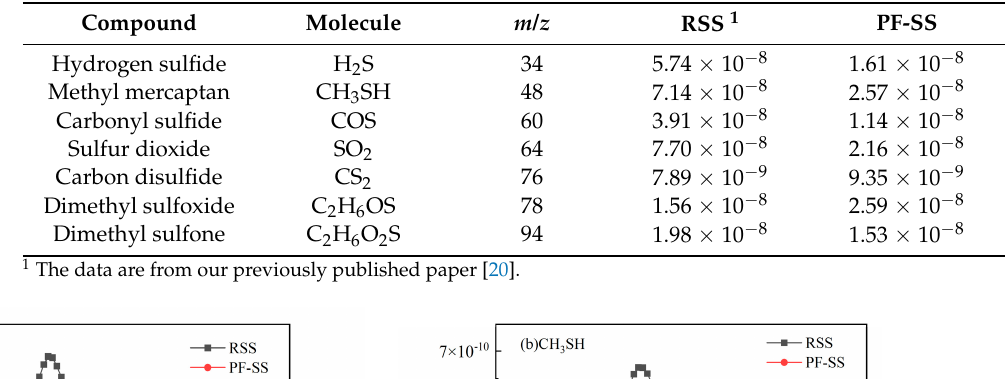
Table 4. Peak integrated areas of products of gases containing S pollutants.